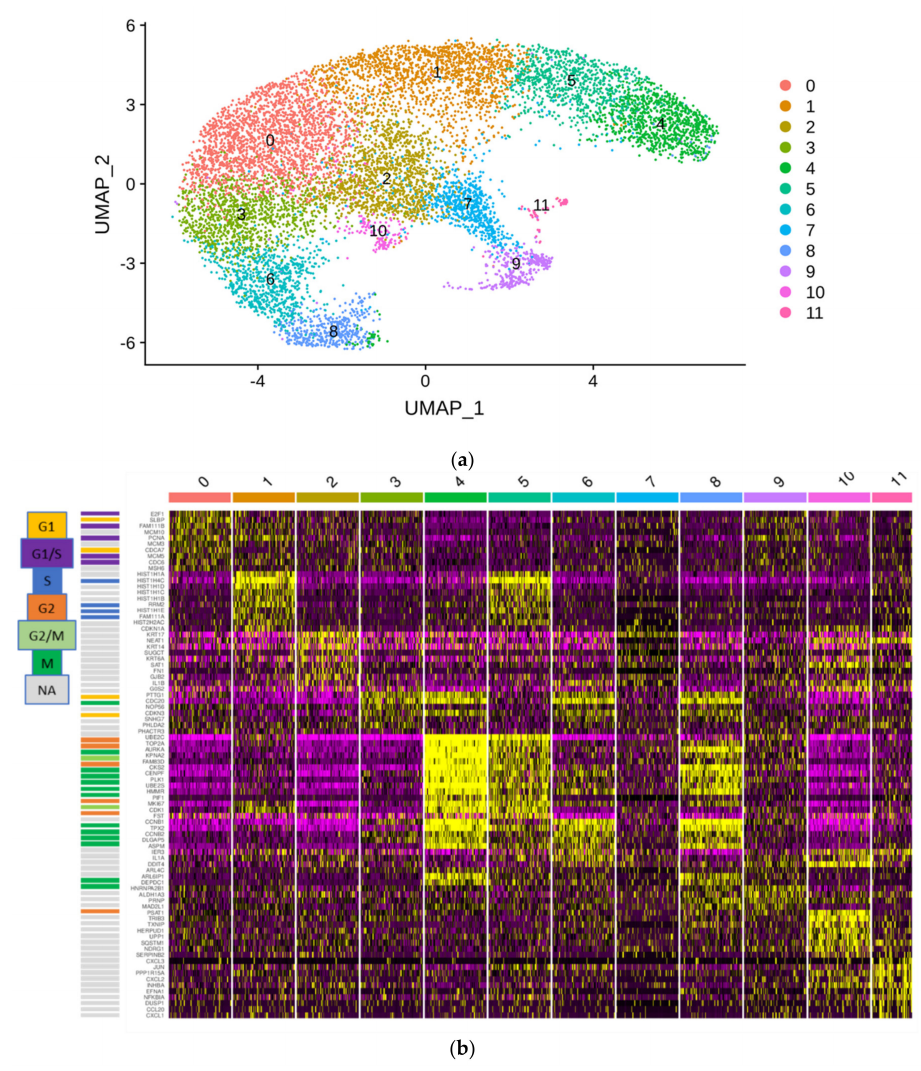
Figure 6. Single cell RNA-seq of the HBLAK cell line. Nearly 10,000 HBLAK cells were analyzed via single cell RNA-seq. ( a ) RNA-seq data analysis with the R toolkit “Seurat” (v3.0) and non-linear dimensional reduction using UMAP (Uniform Manifold Approximation and Projection) identifies 12 cell clusters. ( b ) Gene expression characteristics of the clusters. Expression levels range from purple (low) to yellow (high). Clusters are arranged from left to right; genes are listed on the left side of the main graph. The graphic on top highlights the distinctive gene functions in each cluster. Most clusters are distinguished by marker genes for different cell cycle phases; individual cell cycle genes, according to www.cyclebase.org, are color-coded as indicated in the legend on the very left: cluster 0—G1 / S-phase; cluster 1—S-phase; cluster 3—G1-phase; cluster 4—G2-phase / mitosis; cluster 5—S-phase / G2-phase; cluster 6—G2-phase / mitosis; cluster 8—G2-phase / mitosis (UBE2C negative). Cluster 2 is distinguished by high KRT14 expression and lack of markers of active cell cycling. Smaller additional clusters are associated with reduced oxidative phosphorylation (cluster 7), increased regulation of cell death (cluster 9), increased stress response (cluster 10) and increased positive regulation of immune processes (cluster